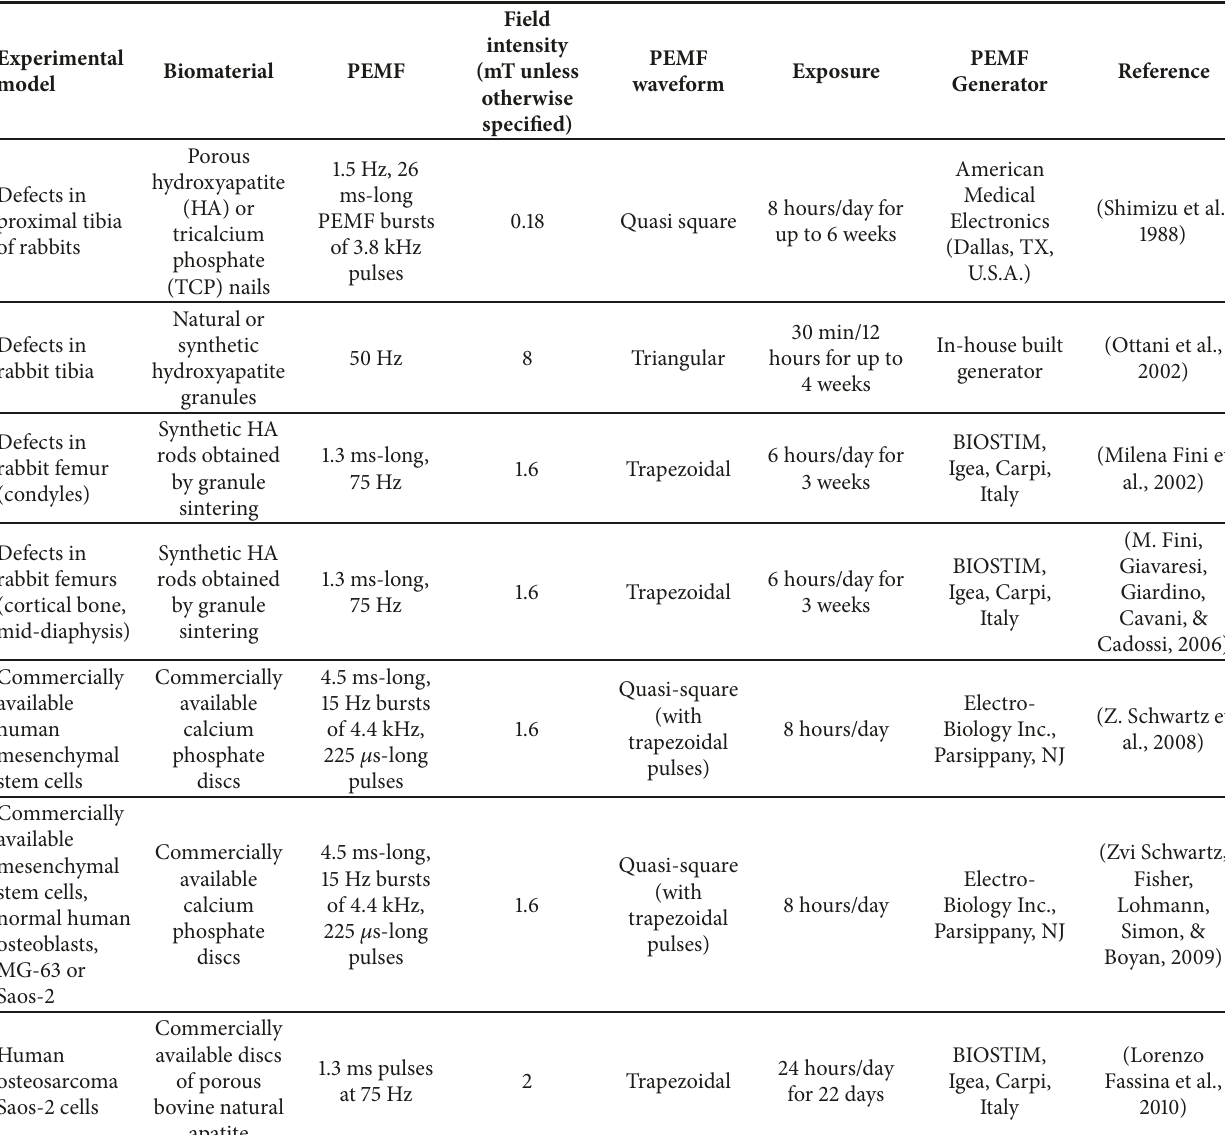
Table 1: The table summarizes the in vitro and in vivo studies on the effects of PEMF stimulation on osteoblastic primary cells and cell lines on calcium phosphate biomaterials. Studies are listed in chronological